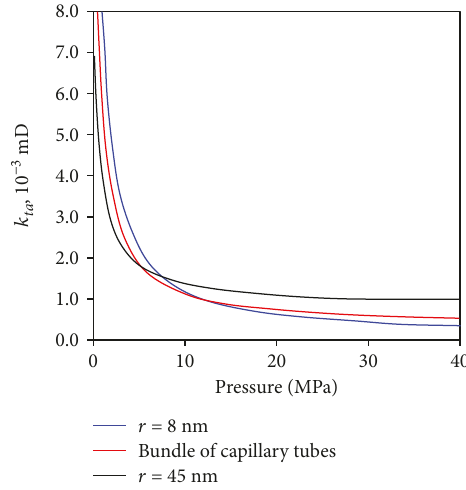
Figure 21: Total apparent permeability of type shale.